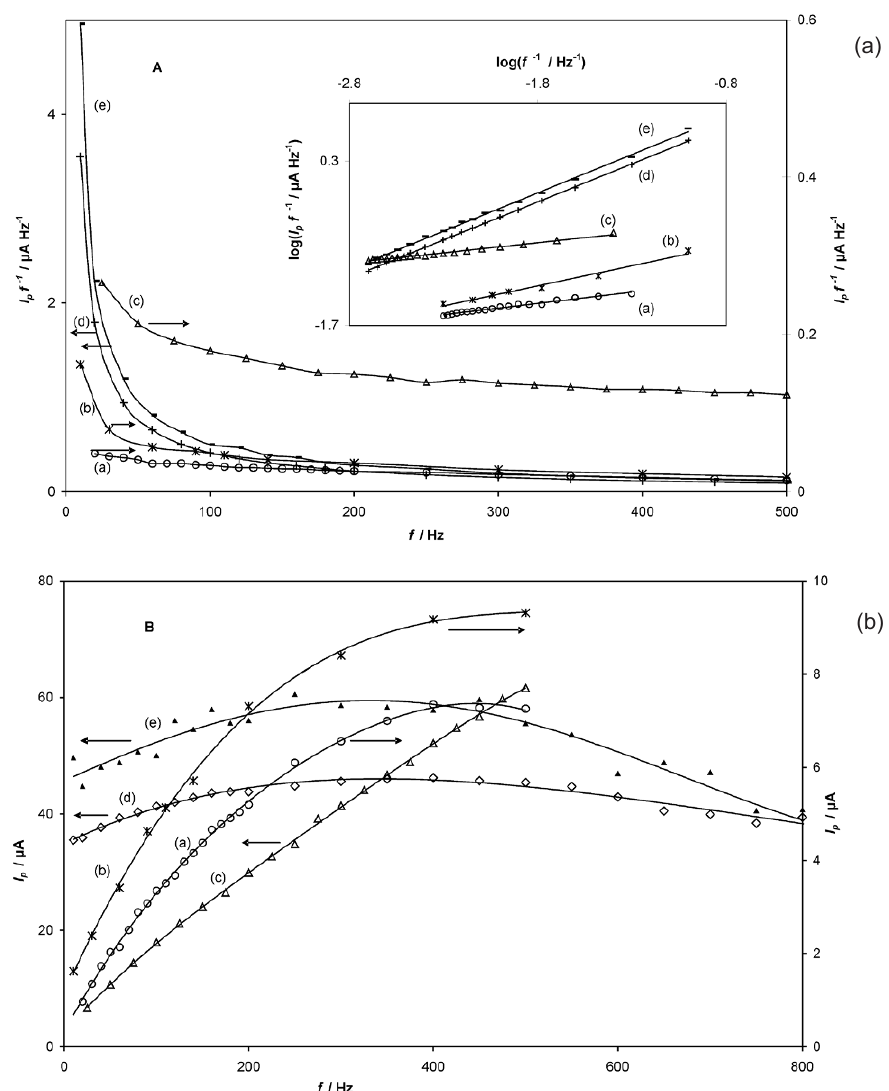
Figure 2. The influence of the frequency ( f ) on the net peak current (I [9], (b) GTAMITU [26], (c) GBI [54], (d) moroxydine [57], and at Hg(Ag)FE for moroxydine (Fig. 2A-e, 2B-e) [57]. The conditions of the experiments were: (a) c(zanamivir) = 3.6×10 -5 mol L -1 , citrate-phosphate buffer pH 2.2, amplitude E E = 9 mV, (b) c(GTAMITU) = 1×10 -5 mol L -1 , citrate buffer pH 2, E s pH 2.5, E = 90 mV and E = 15 mV, (d) c(moroxydine.) = 1 × 10 -5 mol L -1 , phosphate buffer pH 5.85, E sw s (e) c(moroxydine) = 1 × 10 -5 mol L -1 , phosphate buffer pH 6.2, E on the log( 1/f ) recorded at HMDE for (a) zanamivir, (b) GTAMITU, (c) GBI, (d)